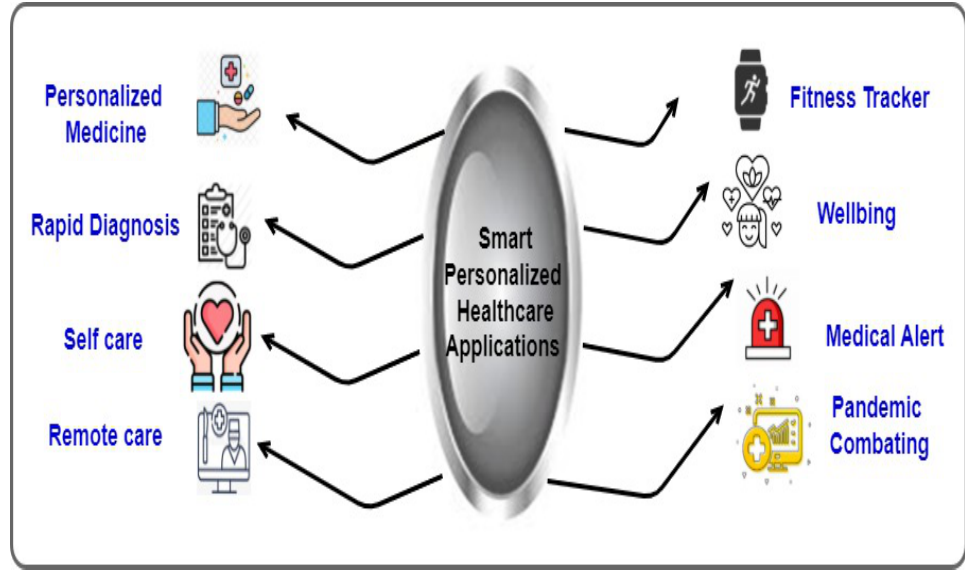
Figure 11. Personal digital twin-based smart personalised healthcare applications